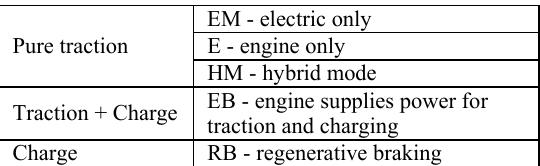
Table 2. Operating